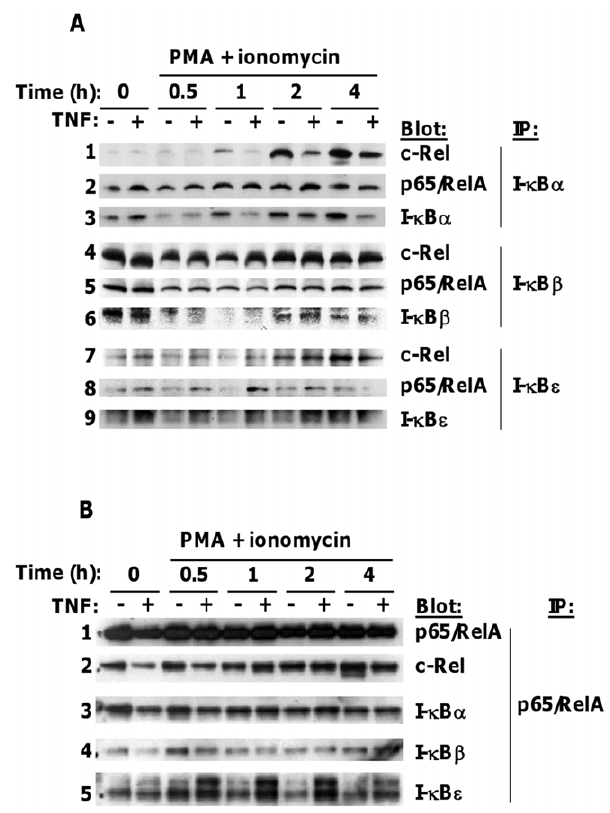
Figure 4. Association of I k B e with newly synthesised c-Rel and p65/c-Rel complexes in TNF-treated cells. Control and TNF-treated 11A2 cells were restimulated with (A) (P + I) high , (B) P + I low , for the indicated times. Nuclear and cytosolic extracts were prepared. (A) I k Bs a , b and e were immunoprecipitated from 100 m g cytosolic protein and immunoblotted for associated c-Rel and p65. (B) p65-containing complexes were immunoprecipitated from 100 m g cytosolic protein and immunoblotted for associated I k B. Blots were probed and reprobed for the indicated proteins and those shown are representative of more than 3 experiments at both concentrations of P +